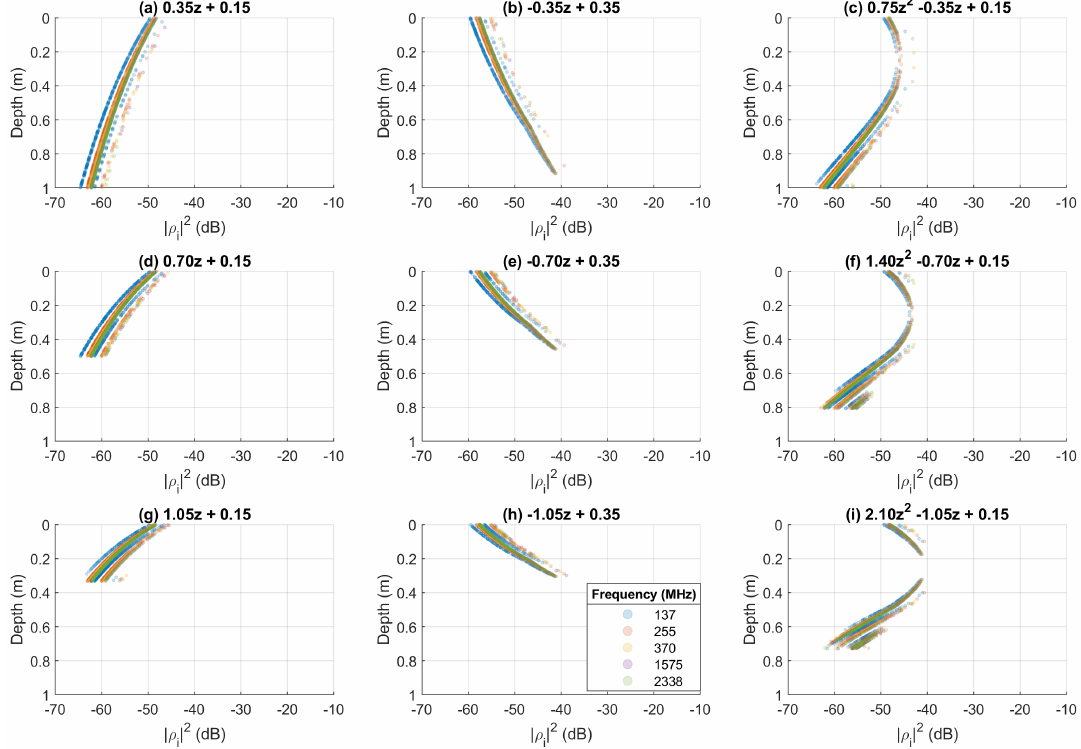
Figure 10. Elementary reflection coefficient in the subsurface of the soil moisture profiles of Figure 9. Each subplot shares a common legend indicating the frequency of each reflection coefficient. Contributions from the air–surface interface are not